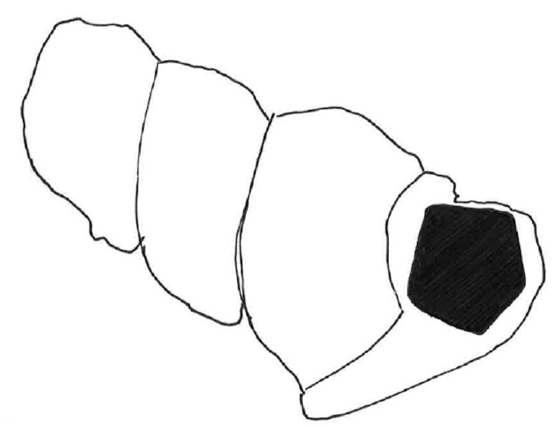
Figure 12. Abyssochrysoid gastropod (IGM 5010b). Scanning electron microscope image showing varix-like ribs and last whorl separating slightly from the previous whorl, forming a channel. Scale bar = 2 mm.